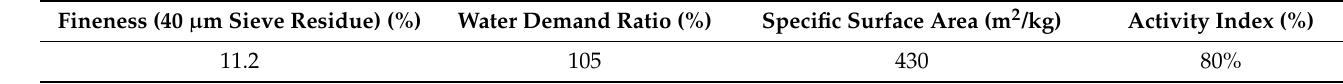
Table 2. Physical properties of fly ash.